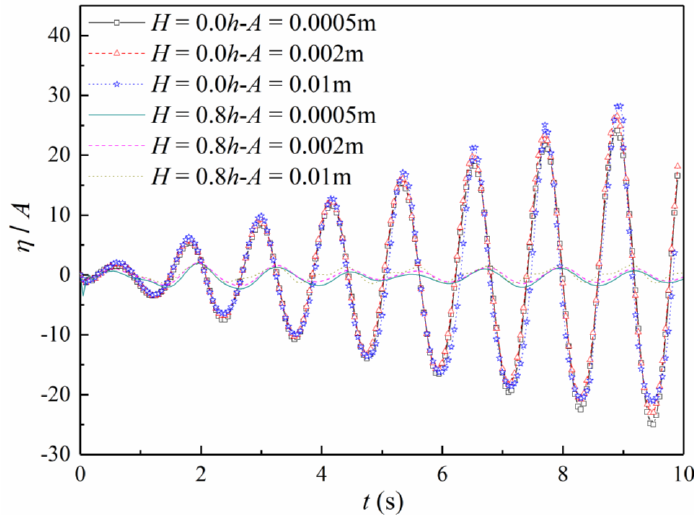
Figure 14. Time series of free surface elevation at y = 0 of sloshing in a tank without or with a vertical baffle under different excitation amplitude.